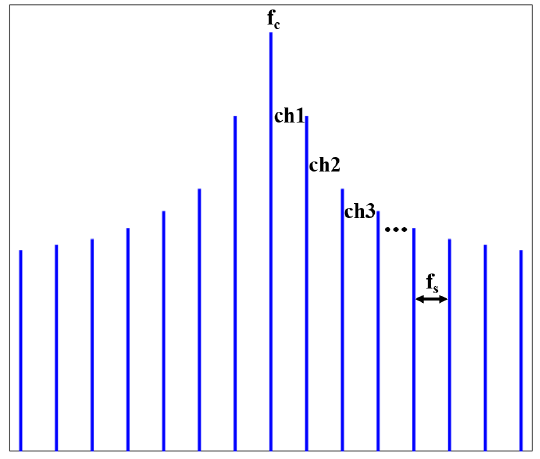
Figure 4. Spectrum diagram of the non-flat OFC.